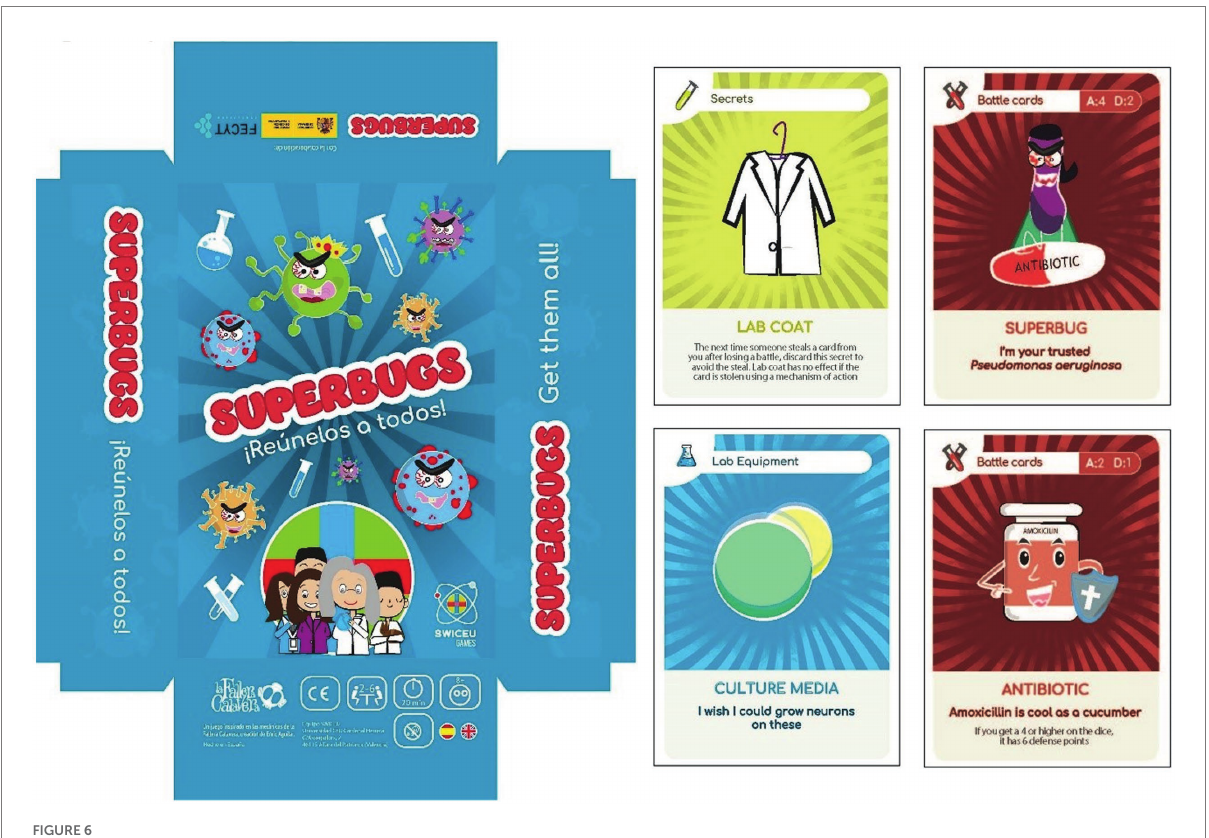
FIGURE 6 Box and card design of the “Superbugs” card